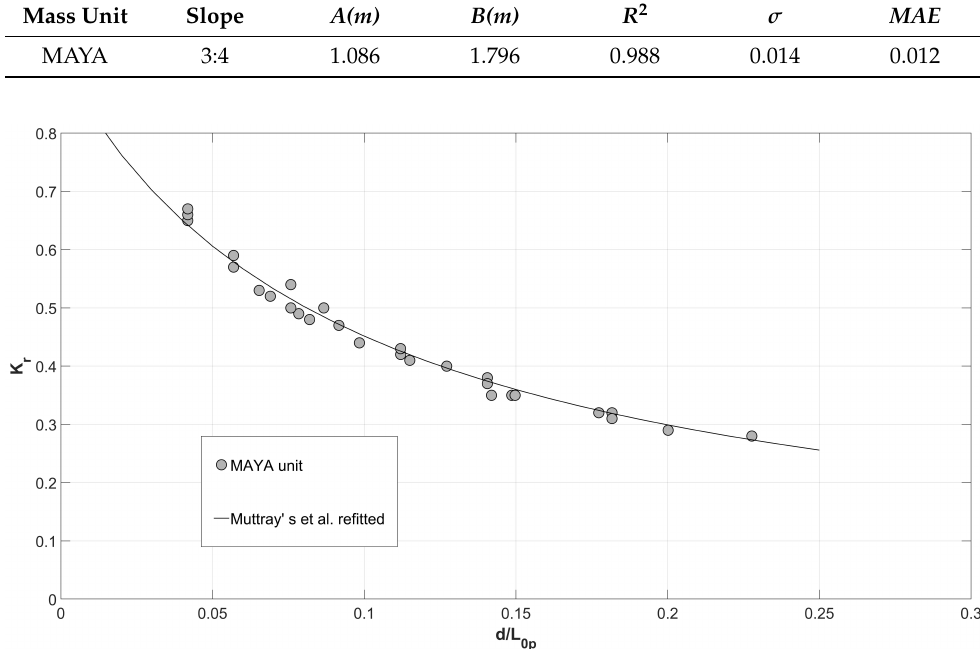
Figure 8. Muttray’s formula refitted using experimental